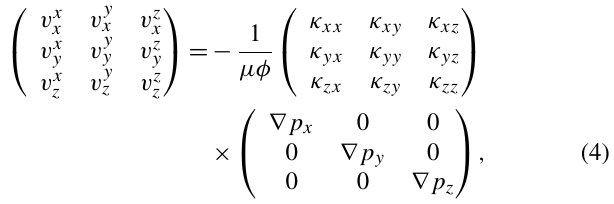
become sufficiently small (Bear, 2013; Halisch, 2013a,